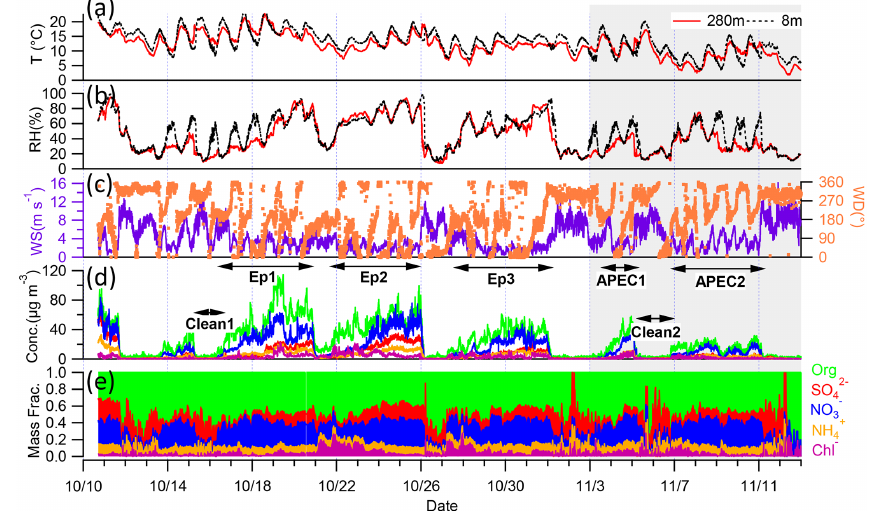
Figure 2. Time series of (a) T , (b) RH, (c) WS and WD, and (d) concentrations of NR-PM 1 species (Org, SO 2 − and (e) mass fraction of each species in NR-PM 1 . Two clean periods and five haze episodes are marked in (d) for further discussions. The meteorological parameters in this figure were all from the tower measurements.